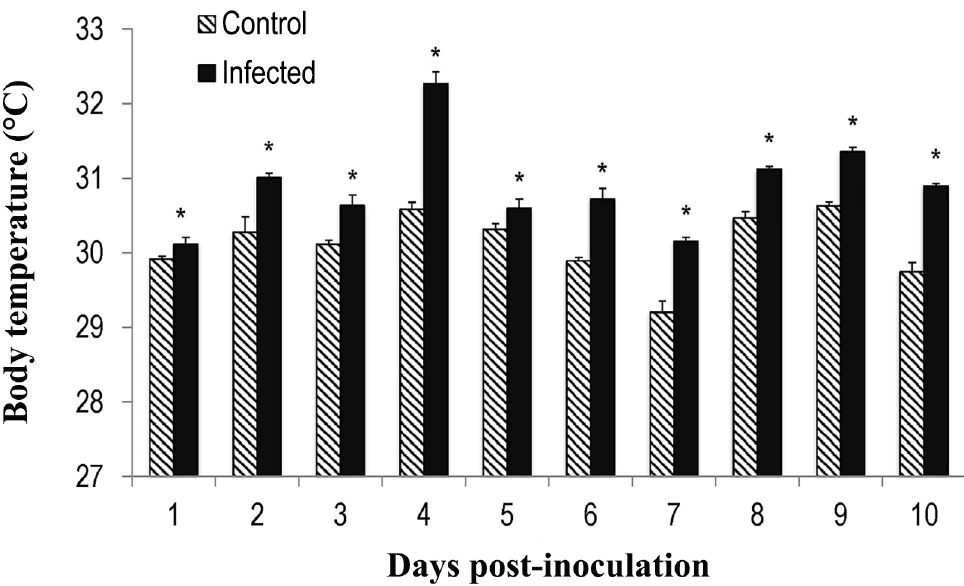
Fig 1. Body temperatures of Locusta migratoria manilensis after infection with Beauveria bassiana . Comparison of the mean daily body temperatures of L . migratoria manilensis inoculated with 10 5 spores of B . bassiana /5 th instar nymph, and the controls (inoculated with sterile distilled water). Asterisks denote a significant difference in body temperature between infected and non-infected insects ( P < 0.05).